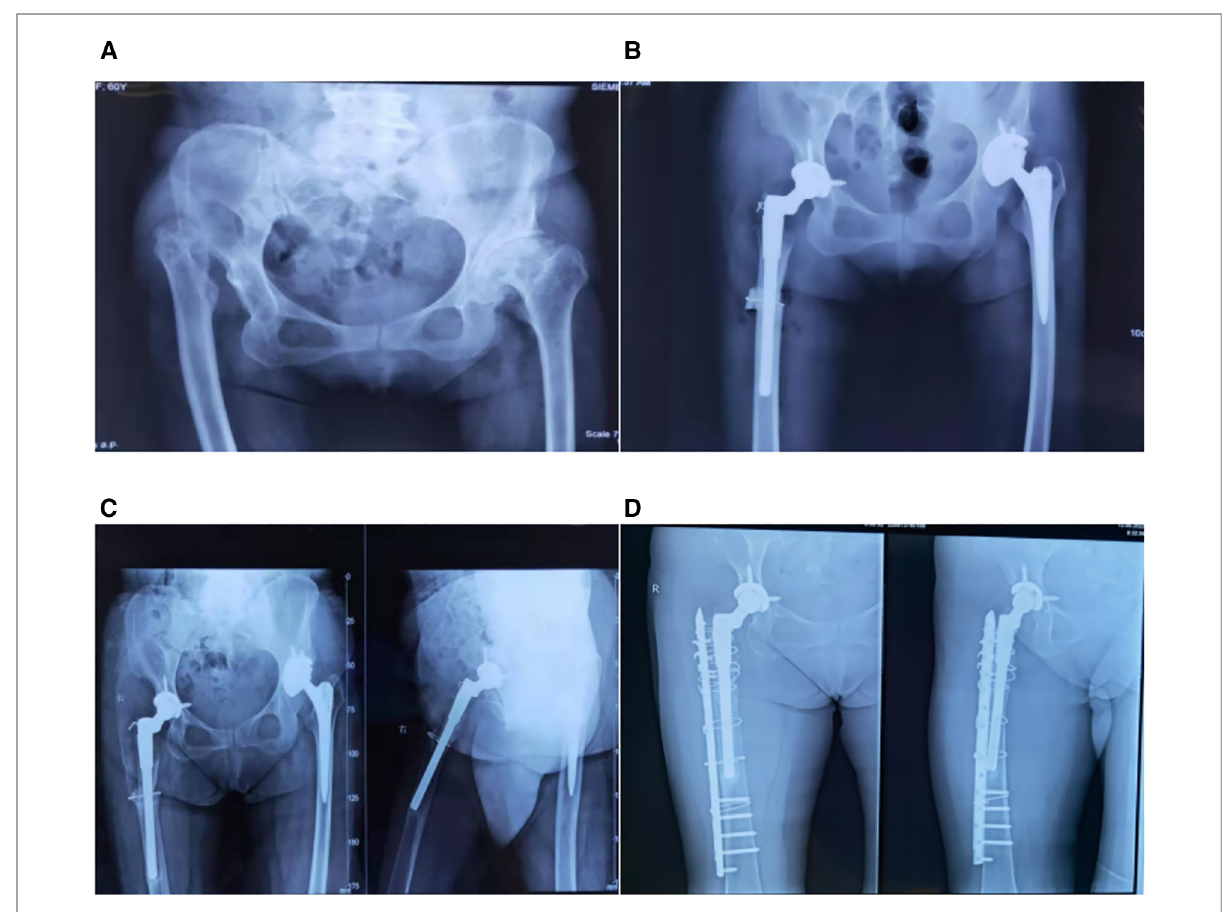
FIGURE 1 ( A ): radiographs of patient 1 prior to THA. On the right is Crowe IV, while on the left is Crowe II. ( B ): It displays patient 1 ′ s hip radiograph following bilateral THA. ( C ): x-ray reexamined two years after the right THA shows loosening of the prosthesis. ( D ): It displays radiographs of the right hip of the patient after revision